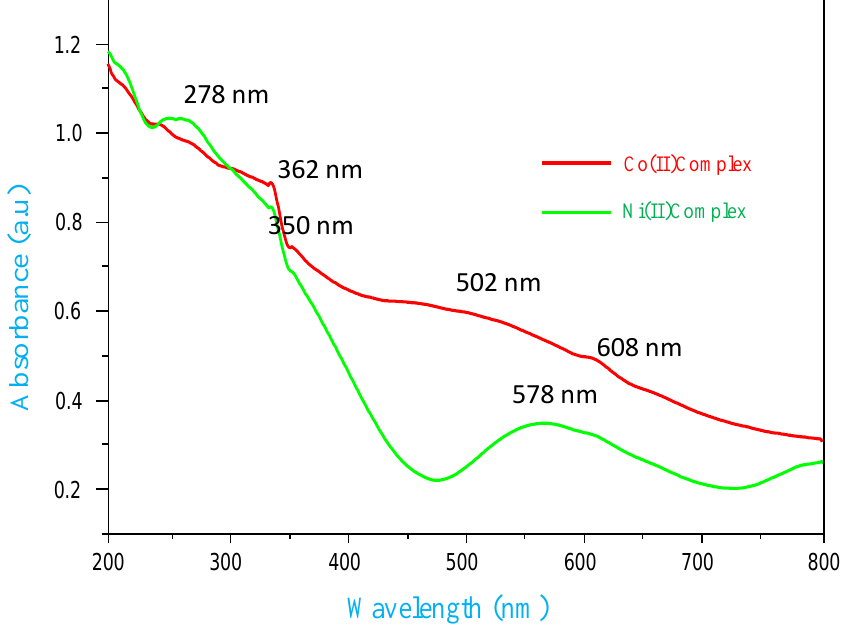
Figure 3. UV-visible spectra of Co(II) and Ni(II) complexes.